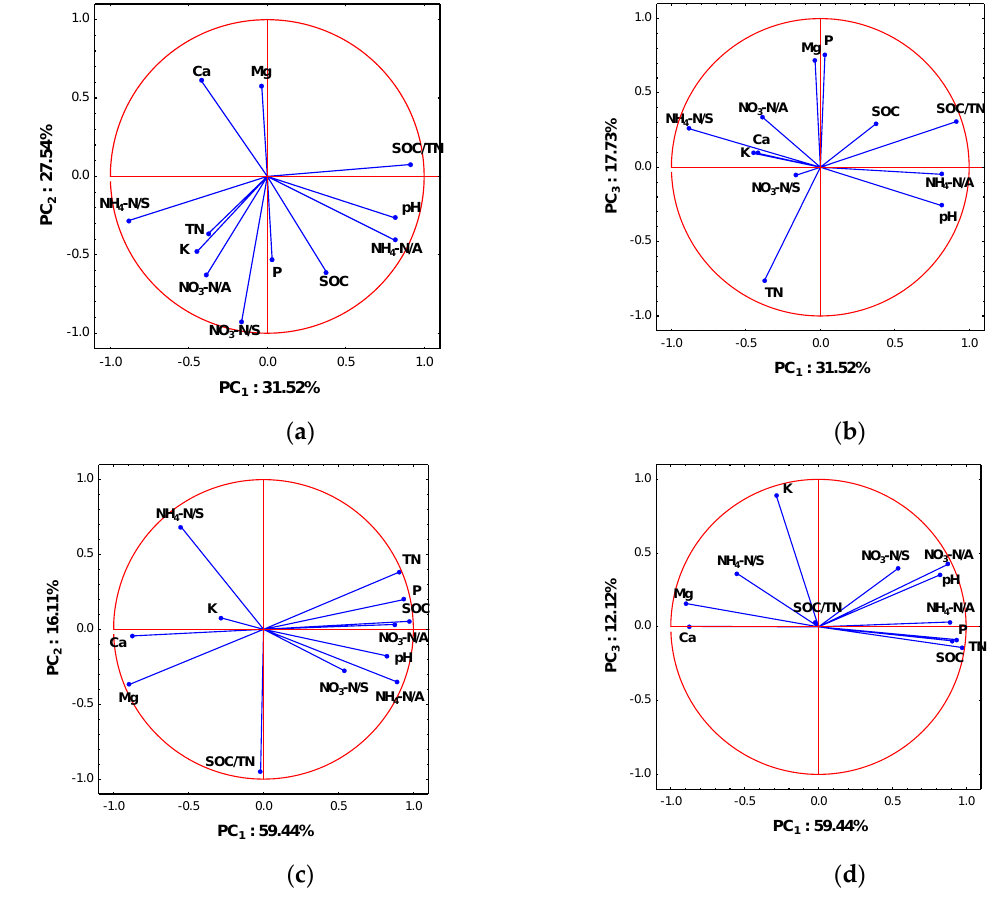
Figure 3. Principal component analysis (PCA) of studied soil parameters: projection of active variables on PCA factor plane for two soil layers: ( a , b ) 0.0–0.3 m and ( c , d ) 0.3–0.6 m. A, autumn; S, spring.